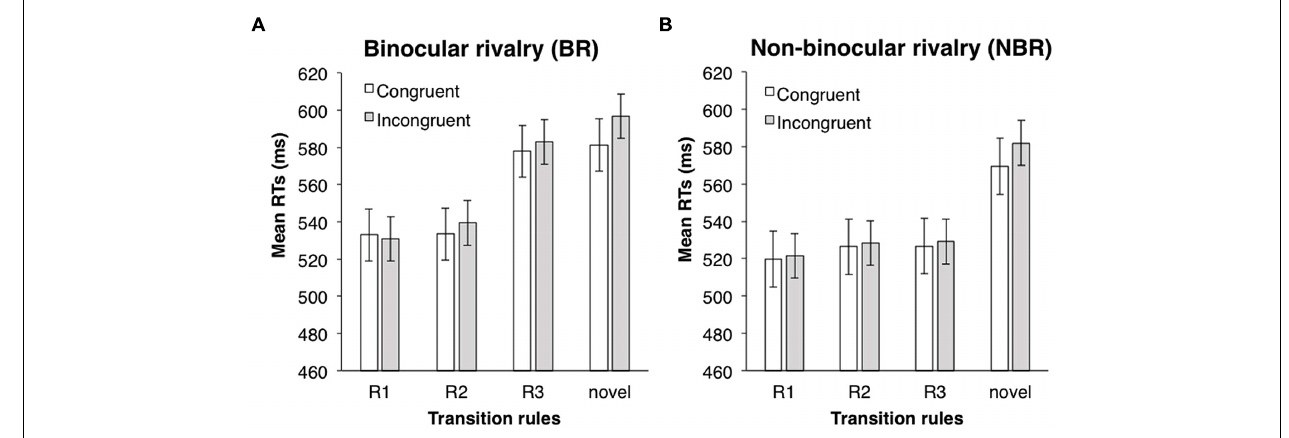
FIGURE 7 | Mean RTs of target detection in Experiment 4. (A) BR condition. (B) NBR condition.White bars indicate the mean RTs in the congruent eye condition; gray bars indicate the mean RTs in the incongruent eye condition. Error bars represent SE.